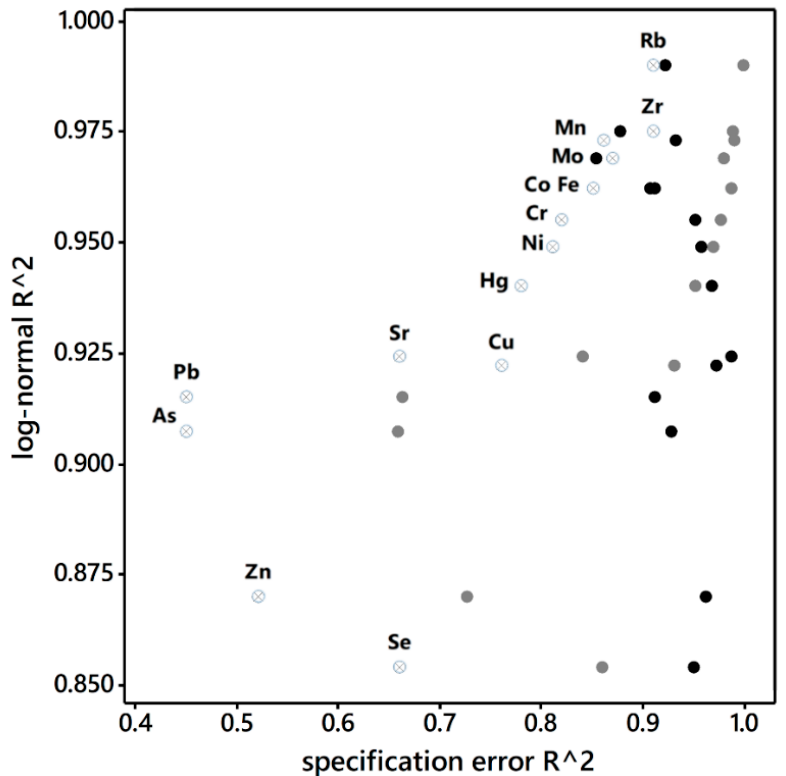
Figure 9. Goodness-of-fit (pseudo-)R 2 scatterplots labelled by heavy metal (each label pertains to a horizontal row of three scatterplot points). Denoted distribution results are: solid black circles denote gamma; solid gray circles denote beta; and, Hebrew pictograms tet ( ⊗ ) denote